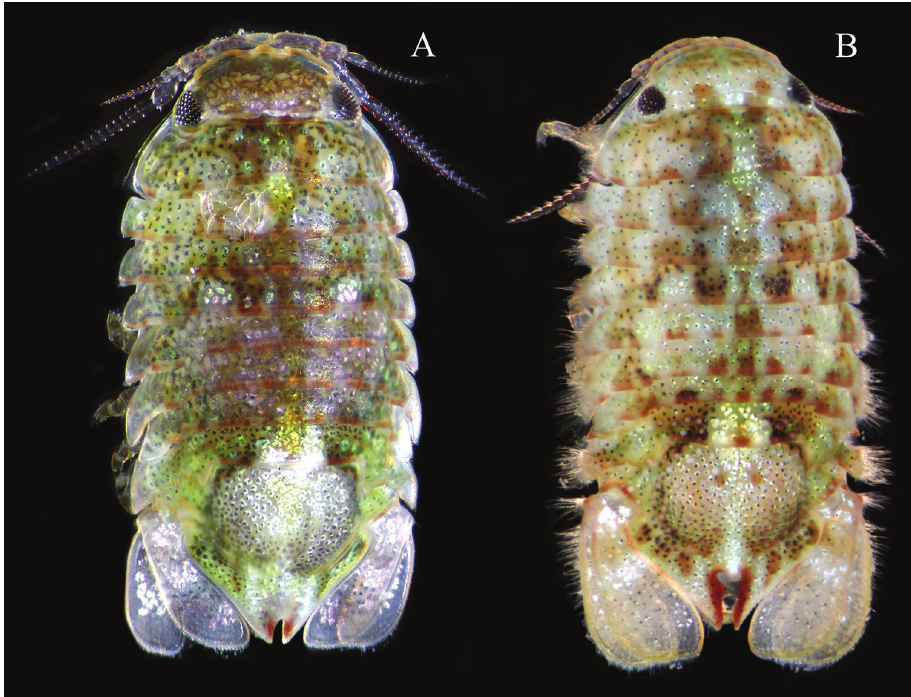
Figure 7. Dynoides elegans . ♂ , non-type. LACM-MBPC 16919. Photographs of live specimens by Leslie Harris. A (3.9 mm) and B (4.0